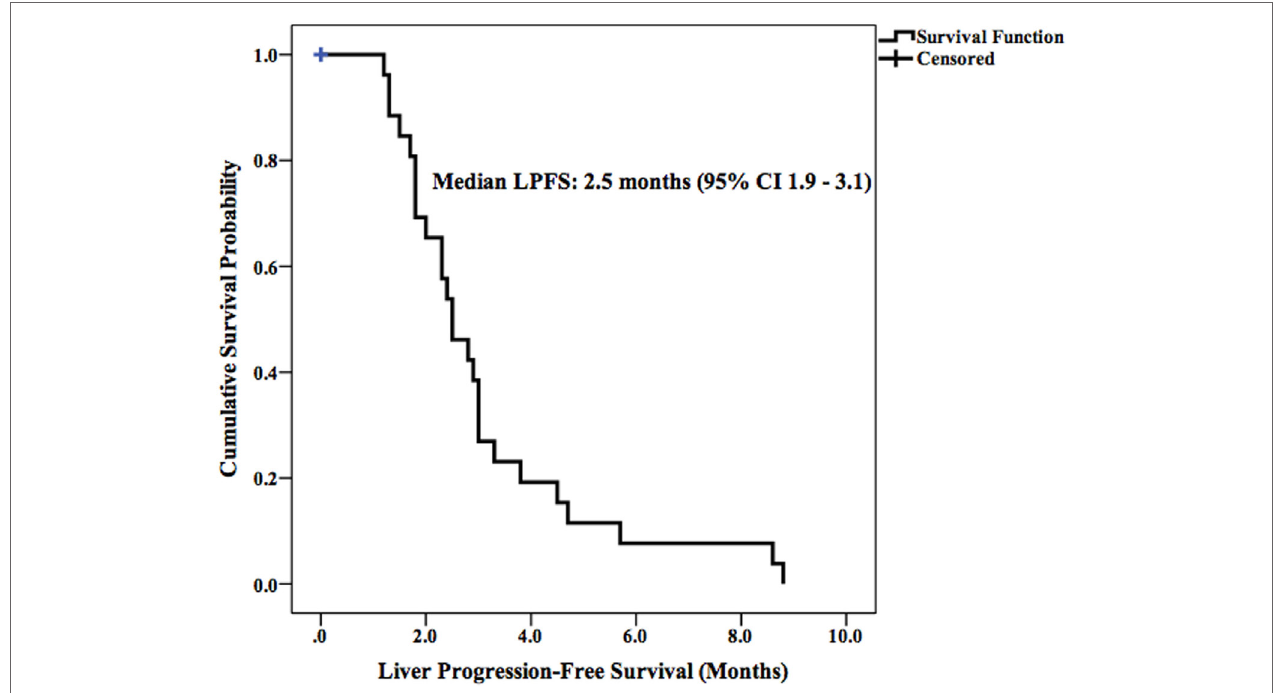
FigUre 2 | Kaplan–Meier curve of lPFs in patients receiving sirT .